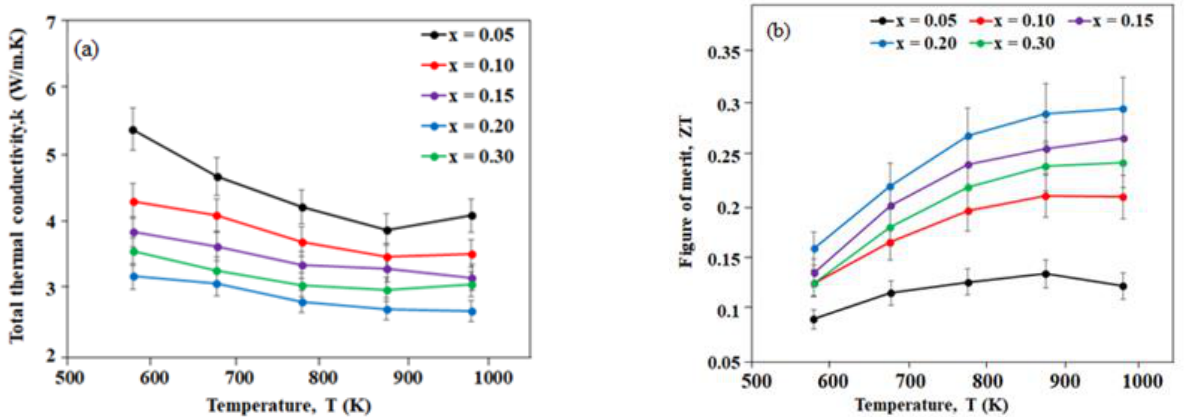
Figure 8. Temperature dependence of ( a ) total thermal conductivity, k , and ( b ) thermoelectric figure of merit, ZT, for VSTO-H ceramics.